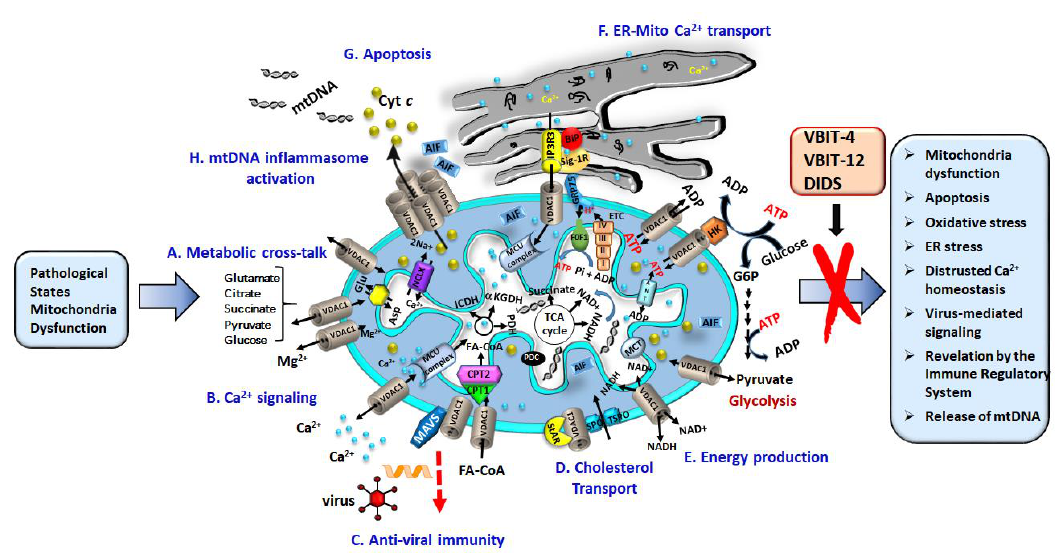
Figure 1. Voltage-dependent anion channel 1 (VDAC1) as a multi-functional channel mediates metabolites, nucleotides, and Ca 2 + transport, controlling energy production, endoplasmic reticulum (ER)-mitochondria cross-talk, and apoptosis. VDAC1 is responsible for a number of functions in the cell and mitochondria including: ( A ) transfer of metabolites between the mitochondria and cytosol; ( B ) passage of Ca 2 + to and from the intermembrane space (IMS) to facilitate Ca 2 + signaling; ( C ) Mitochondrial antiviral-signaling protein (MAVS) associated with VDAC1 enable anti-viral signaling. ( D ) Transfer of acetyl coenzyme-A (acyl-CoAs) across the outer mitochondrial membrane (OMM) to the IMS, for conversion into acylcarnitine by CPT1a for further processing by β -oxidation. Together with Star and translocator protein (TSPO), VDAC1 forms the multi-protein transduceosome, which transports cholesterol. ( E ) Recycling ATP / ADP, NAD +/ NADH, and acyl-CoA between the cytosol and the IMS, and regulating glycolysis via association with HK; ( F ) contributing to ER-mitochondria contacts, where Ca 2 + released by IP3 activation of inositol 1,4,5-trisphosphate receptors (IP 3 R) in the ER is directly transferred to IMS via VDAC1, and then is transported to the matrix by the Ca 2 + uniporter (MCU complex). In the matrix Ca 2 + regulates energy production via activation of the tricarboxylic acid cycle (TCA) cycle enzymes: pyruvate dehydrogenase (PDH), isocitrate dehydrogenase (ICDH), and α -ketoglutarate dehydrogenase ( α -KGDH). The electron transport chain (ETC) and the ATP synthase (FoF1) are also presented. ( G ) VDAC1 oligomers forming a hydrophilic protein-conducting channel capable of mediating the release of apoptogenic proteins (e.g., Cyto c and apoptosis-inducing factor (AIF)) from the mitochondrial IMS to the cytosol, leading to apoptosis. ( H ). VDAC1 oligomers allow mtDNA release triggering inflammasome activation. Pathological conations lead to dysfunction of the mitochondria as reflected in the activities presented in the box on the right. These altered